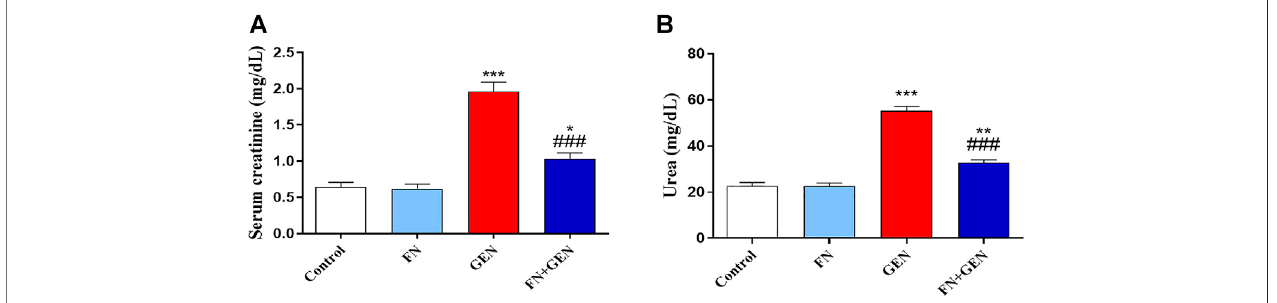
FIGURE 1 | FN attenuates renal function in GEN-induced rats. FN attenuated (A) creatinine and (B) urea in the serum of GEN-intoxicated rats. Data are mean ± SEM ( n = 6). p indicates p < 0.05, pp indicates p < 0.01, and ppp indicates p < 0.001 versus control group, while ### indicates p < 0.001 versus GEN group. FN: formononetin; GEN: gentamicin.